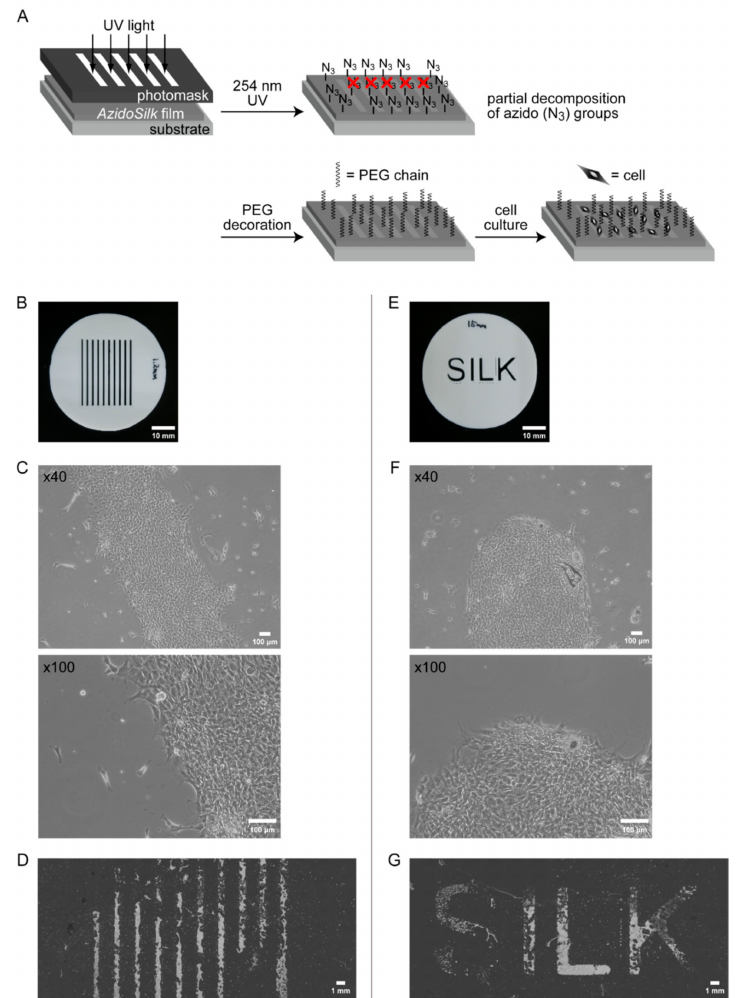
Figure 5. Spatial patterning of NIH3T3 fibroblasts on AzidoSilk film modified with DBCO-mPEG of 20 kDa chain length after partial irradiation of 254 nm UV light through patterned photomasks. Fibroblasts were cultured for 3 days in Eagle MEM supplemented with 10% FBS. ( A ) Experimental procedure. UV light was first irradiated to AzidoSilk film through a photomask for the partial decomposition of azido groups. After the PEG chain decoration, cells were cultured on the AzidoSilk film. ( B , E ) Photomasks used in this study. Scale bars are 10 mm. ( C , F ) Fibroblasts on the boundary of UV-irradiated and nonirradiated areas on the third day of culturing. Scale bars are 100 µ m. ( D , G ) Wide views showing patterned adhesion of fibroblasts. Culture medium was removed, and cells were immobilized by 100% methanol followed by drying. Cells turned into white after fixation. Scale bars are 1